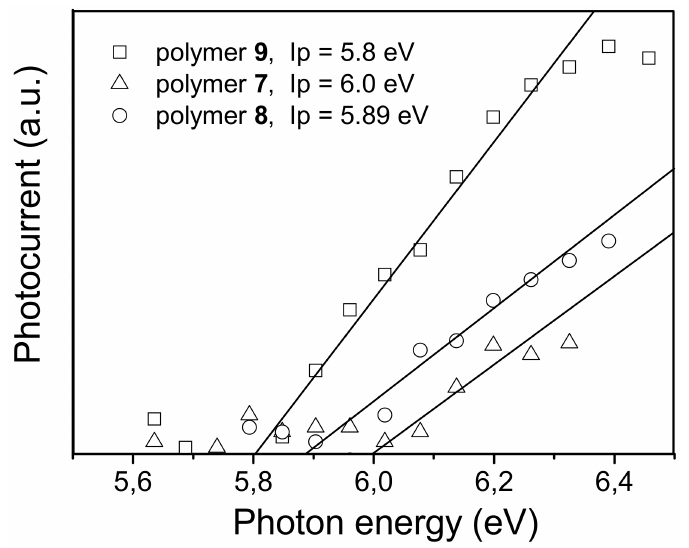
Figure 2. Electron photoemission spectra of thin layers prepared using the polymers 7 – 9